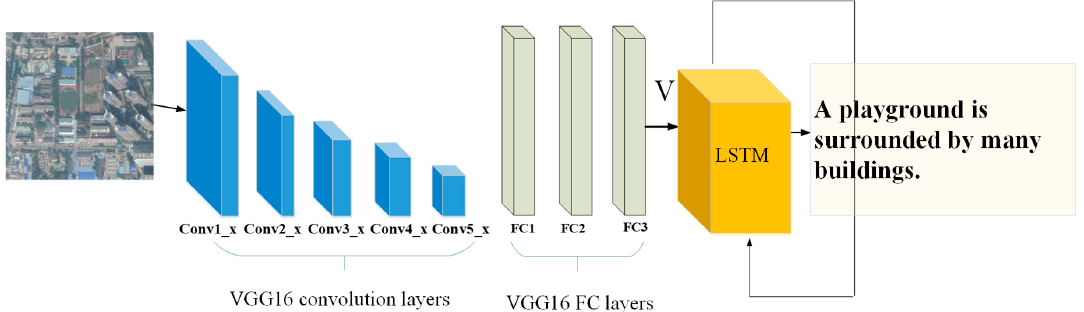
Figure 7. The structure of multimodal method.